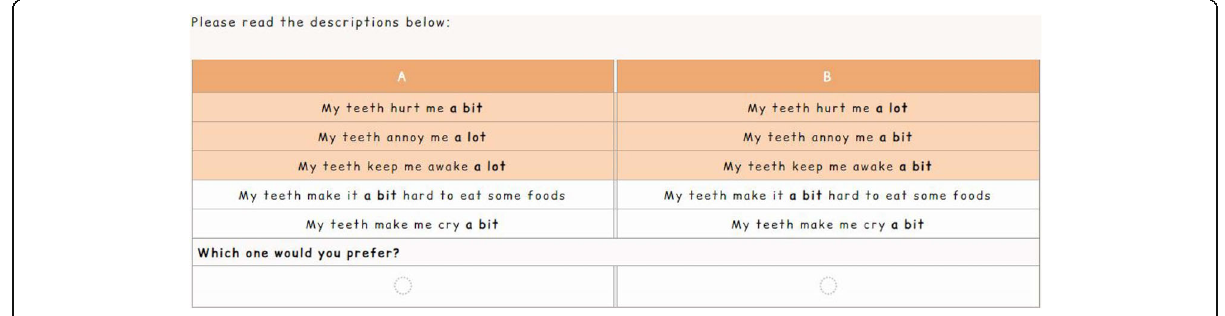
Fig. 1 Example of a discrete choice experiment task from the